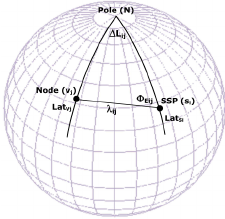
Figure 4. Gateway of sensorfiel geometry[12].